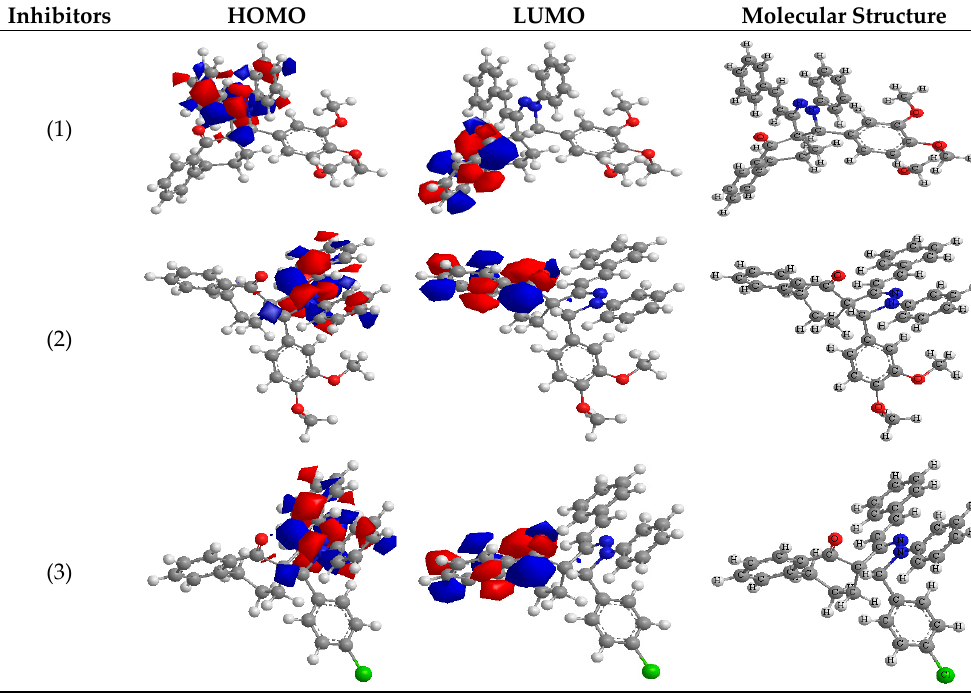
Figure 10. Molecular orbital bends of study spiropyrazoles.